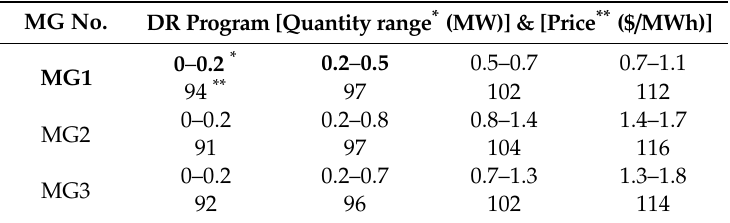
Table 3. Bid quantity o ff er packages of DR programs [31].